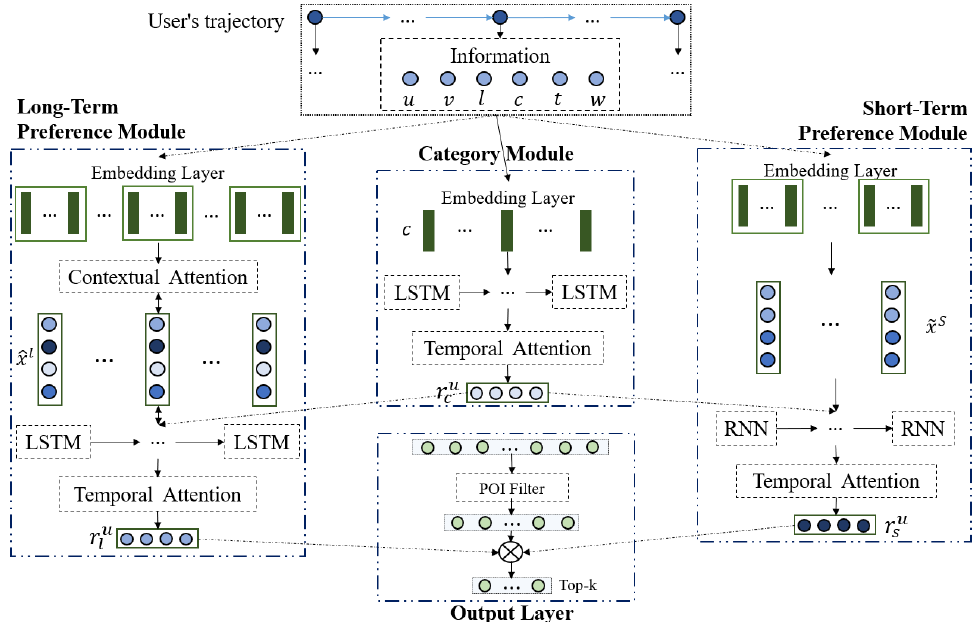
Figure 4. The proposed LSMA